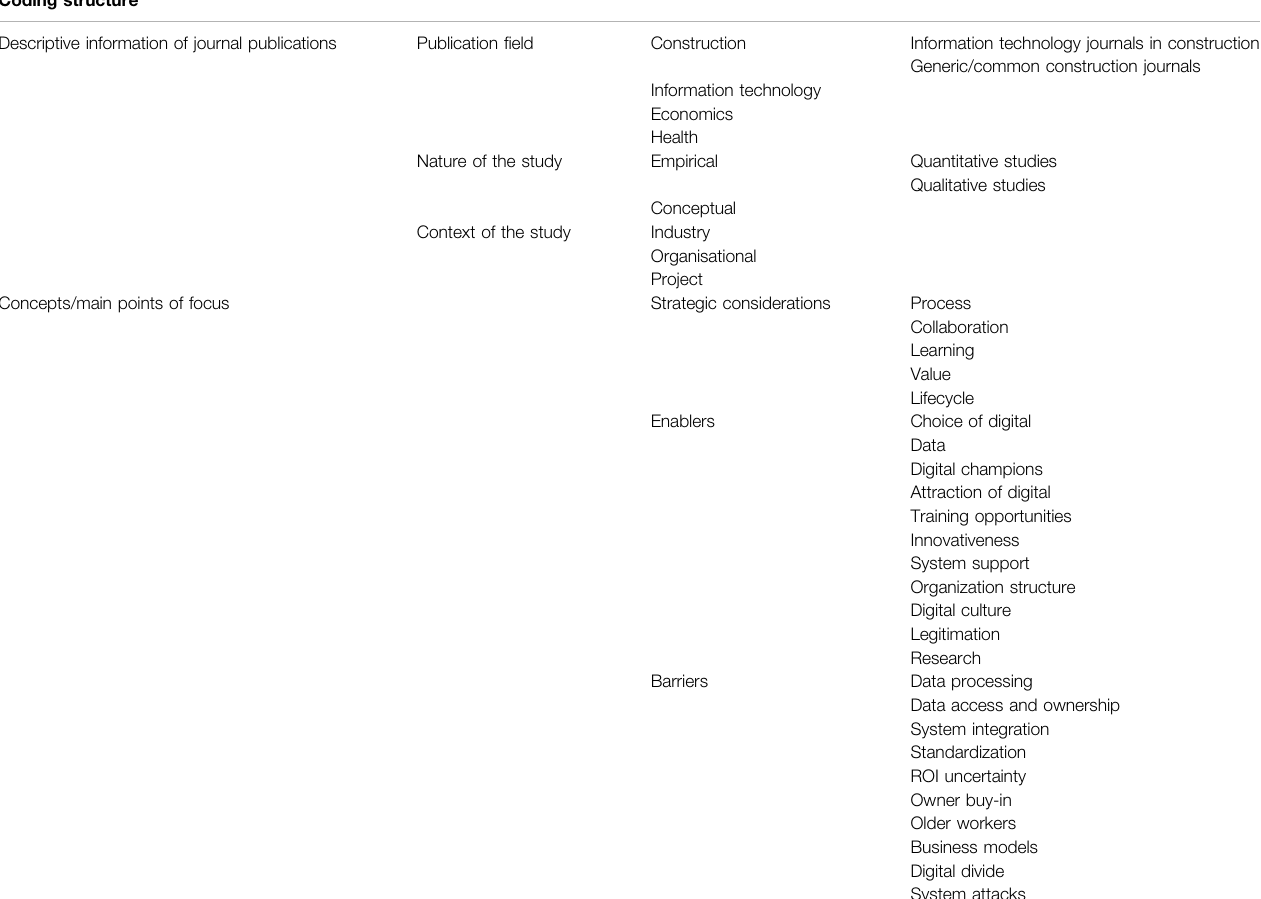
TABLE 2 | Coding structure of the fi nal